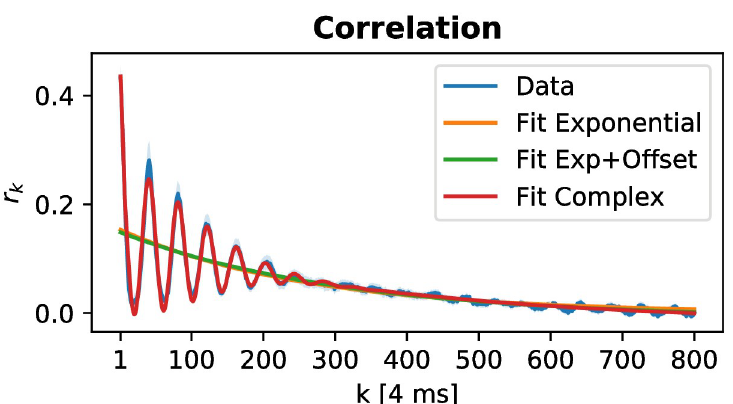
Fig 2. Example analysis of spiking activity from rat hippocampus during an open field task that demonstrates the usage of the complex fit function. A short example code that analyzes the data [30] and produces this figure is listed in appendix